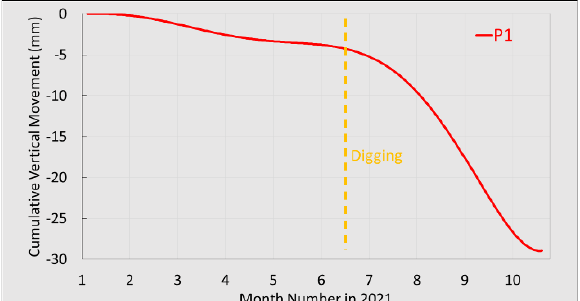
Figure 13. Cumulative vertical movement of P1 (Figure 12). Mining occurred in middle June.